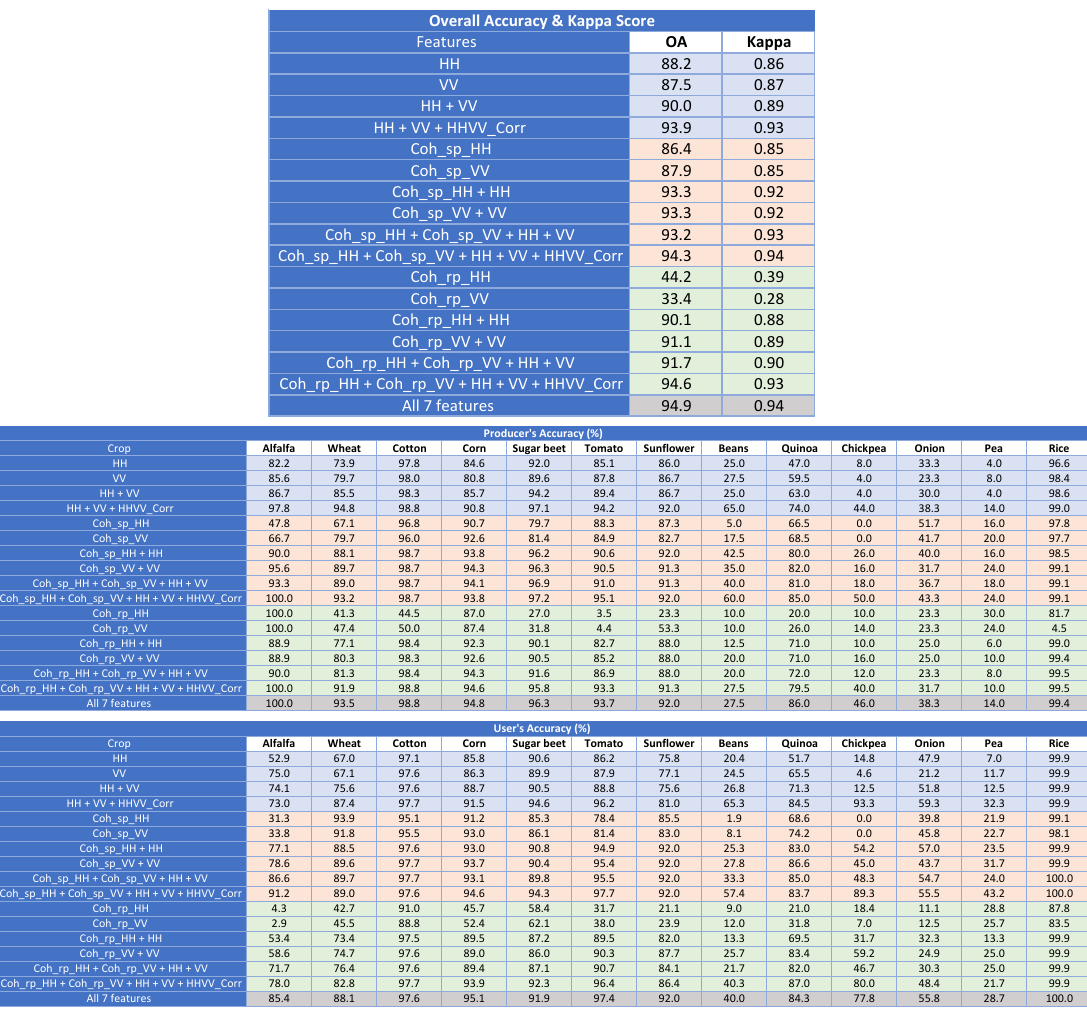
Table 5. Classification scores at field level with HH and VV channels. Shading colour: blue for polarimetric features, pink for single-pass interferometric coherence features, green for repeat-pass interferometric coherence features, and grey for all